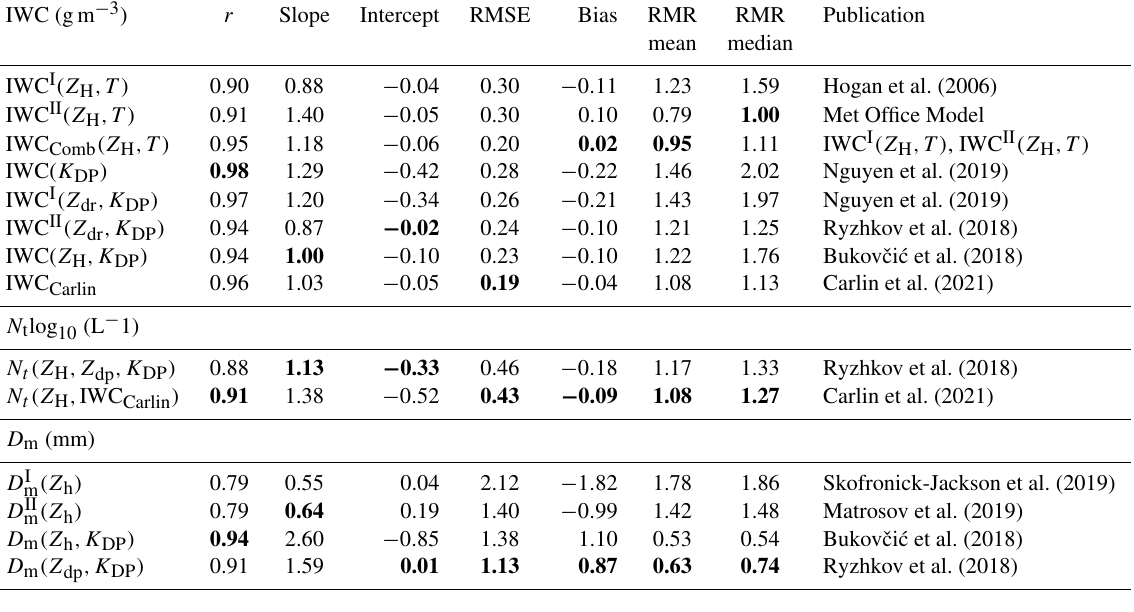
Table 3. Correlations ( r ), slopes, and intercepts from least-squares fits, root mean square error (RMSE), biases, and mean and median retrieved-to-measured ratio (RMR) for each microphysical property and for all retrievals. Best values of each statistical measure across every microphysical retrieval type are highlighted in boldface font.